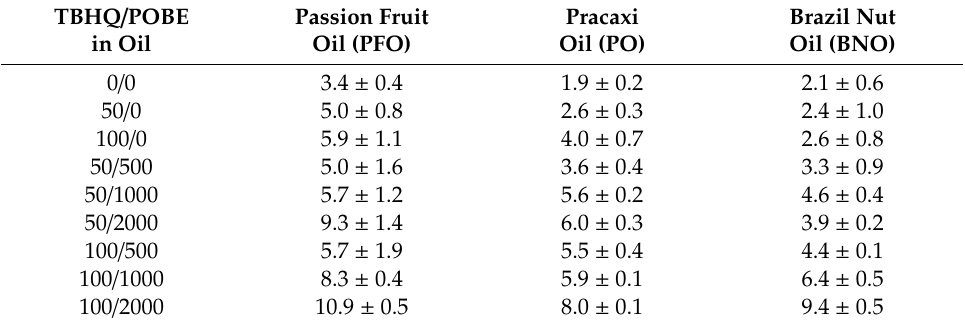
Table 5. Influence of TBHQ / POBE (ppm / ppm) blends on the oxidative induction period (h) of reference vegetable